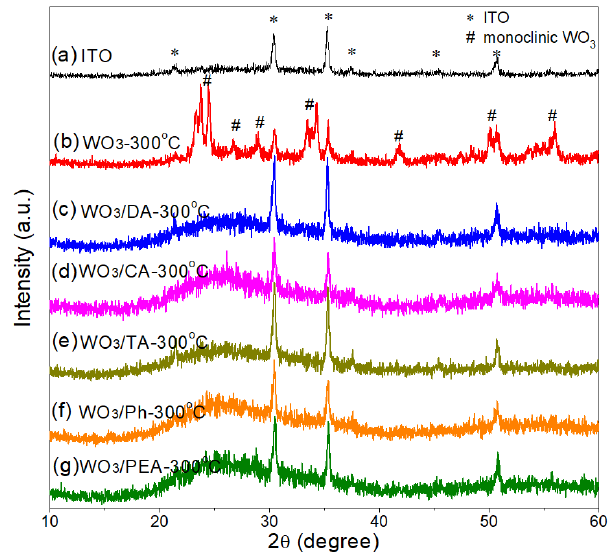
Figure 5. X-ray di ff raction (XRD) pa tt erns of (a) ITO glass, (b) WO 3 -300 °C, (c) WO 3 /DA-300 °C, (d) Figure 5. X-ray diffraction (XRD) patterns of (a) ITO glass, (b) WO 3 -300 ◦ C, (c) WO 3 /DA-300 ◦ C, (d) WO 3 /CA-300 ◦ C, (e) WO 3 /TA-300 ◦ C, (f) WO 3 /Ph-300 ◦ C, and (g) WO 3 /PEA-300 ◦ C films. WO 3 /CA-300 °C, (e) WO 3 /TA-300 °C, (f) WO 3 /Ph-300 °C, and (g) WO 3 /PEA-300 °C fi lms.